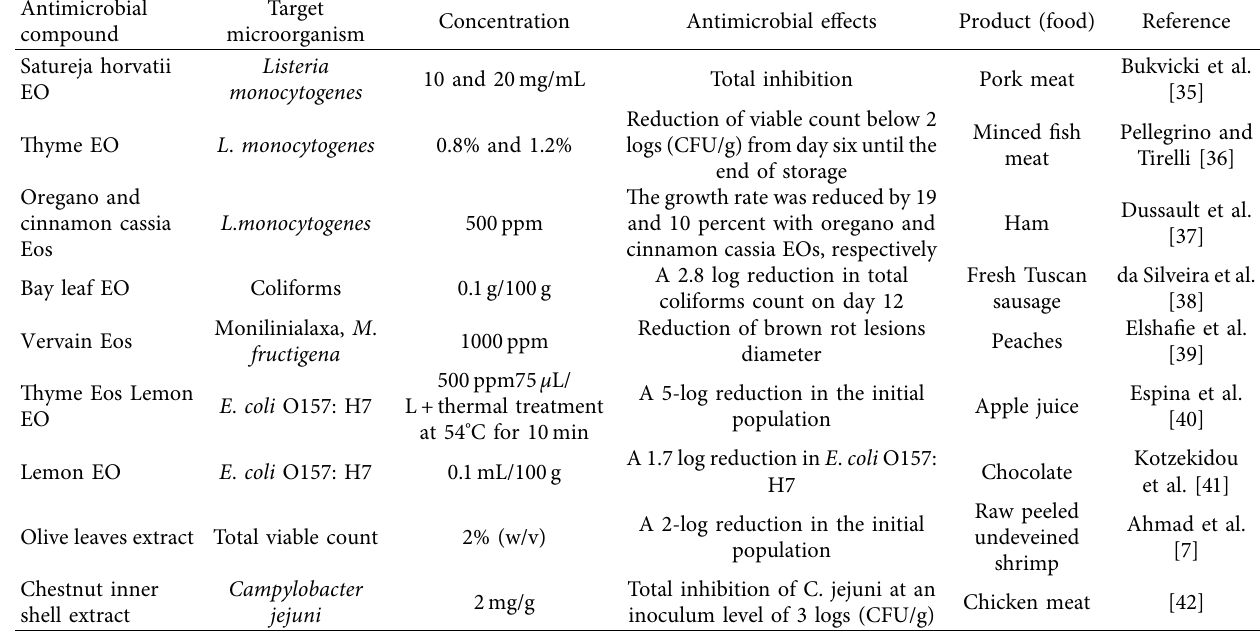
Table 1: Antimicrobial effect of plant-derived extracts in the food system.